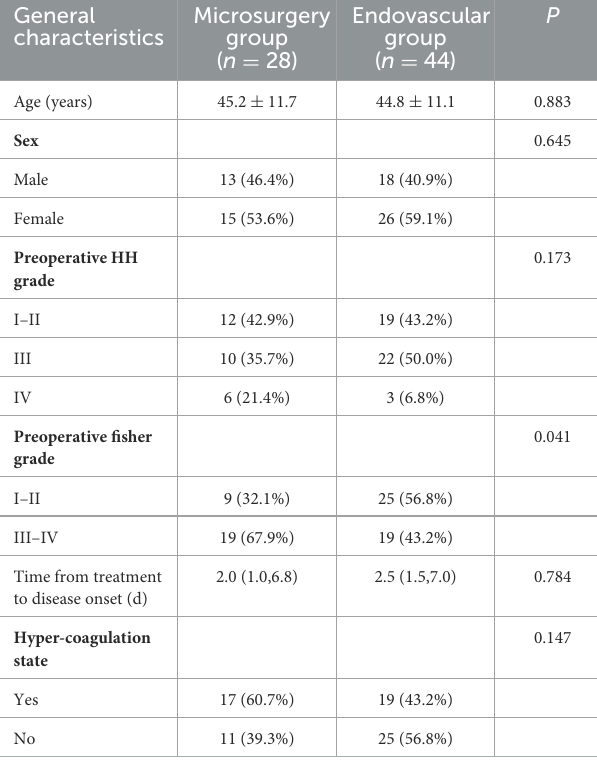
TABLE 1 Comparison of the general characteristics of 72 patients with BBA between the microsurgery and endovascular groups. General